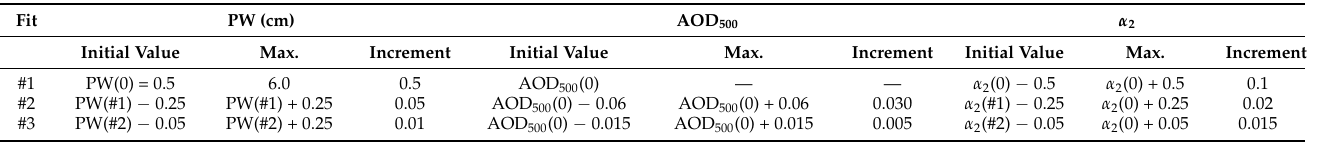
Table 2. Initial values, maximum values, and increments for the estimation of three key SMARTS inputs when using iterative fits. The three consecutive fits are denoted as #1, #2, and